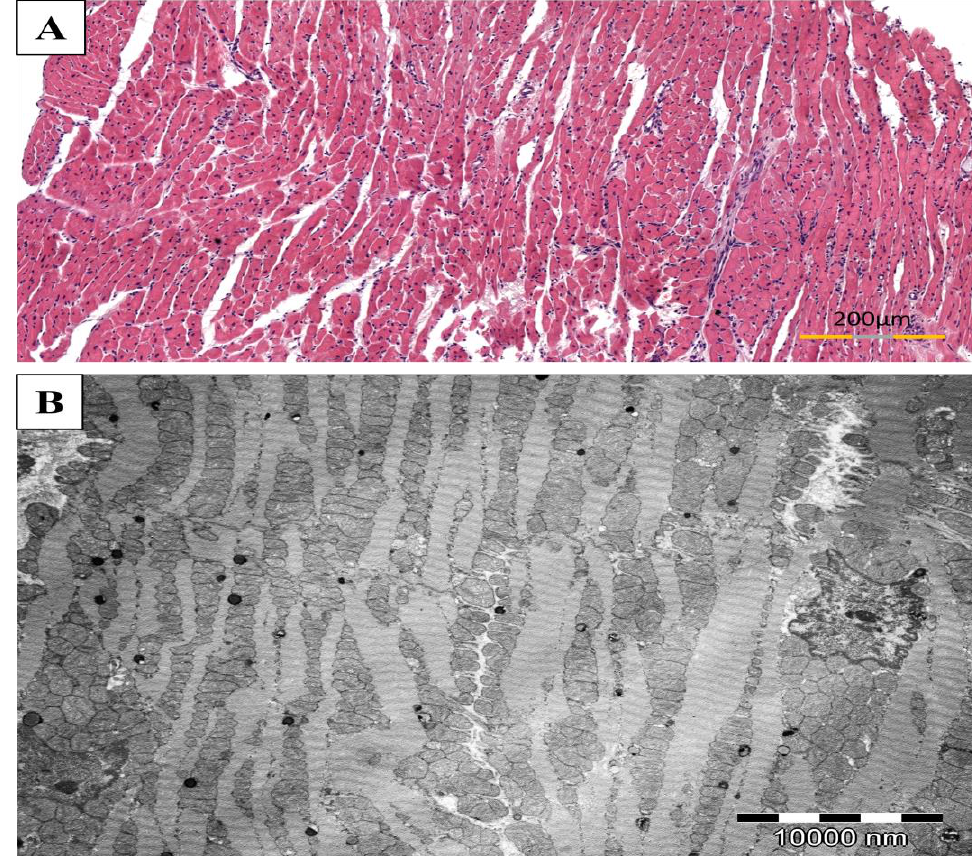
Figure 4. The representative images of cardiac muscle from not immunized rats without simvastatin (group C). The healthy heart without mononuclear cell infiltrates (( A ), HE stain) and a typical ultrastructure of heart with proper cross striations and abundant mitochondria (( B ), TEM). The most severe inflammatory cell infiltrations in the perimysium and between cardiomyocytes were observed in the untreated rats with induced EAM (group EAM). The inflammatory cells formed thick aggregations. In turn, in the EAM+S30 group (high-dosage simvastatin) and in the EAM+S3 group were observed less severe, diffuse mononuclear cells infiltrate. The largest severity of inflammation occurred in the subendocardial area. Inflammatory infiltrates were composed of neutrophils, lymphocytes, macrophages, and plasma cells. The multinuclear giant cells were also seen, mostly in the rats of group EAM and EAM+S3, and were delimited to the most severe infiltration area (Figure 5). In EAM+S30 group a severity of inflammation was significantly lower in comparison with EAM rats (3.17 ± 0.49 vs. 3.9 ± 0.12, n = 5, p < 0.05) (Figure